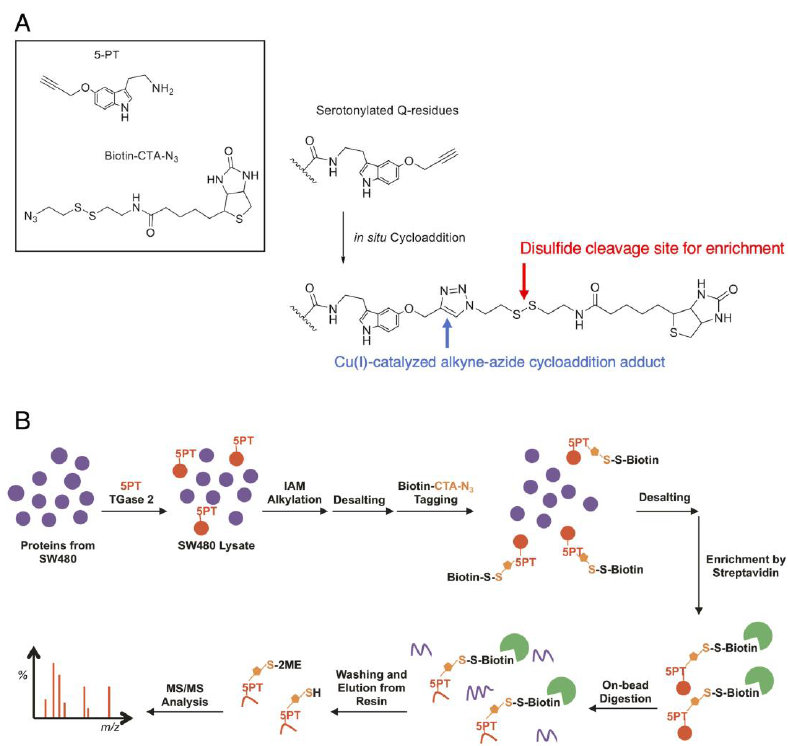
Figure 4. Protein serotonylation by 5-propargylserotonin: ( A ) The approach utilizes the click reaction between 5-propargylserotonin (5-PT) and biotinylazido-cystamine (biotin-CTA-N3, both as shown in the box in the upper left) as a TGM2 surrogate for 5-HT. The conjugation occurs in situ to produce a triazole adduct (right, blue arrow) that is stable under mass spectrometry. When a cleavable moiety is integrated into the linker, e.g., a disulfide structure (right, red arrow), the biotin moiety can be cleaved for elution. ( B ) A proteomic workflow to enrich serotonylated proteins.